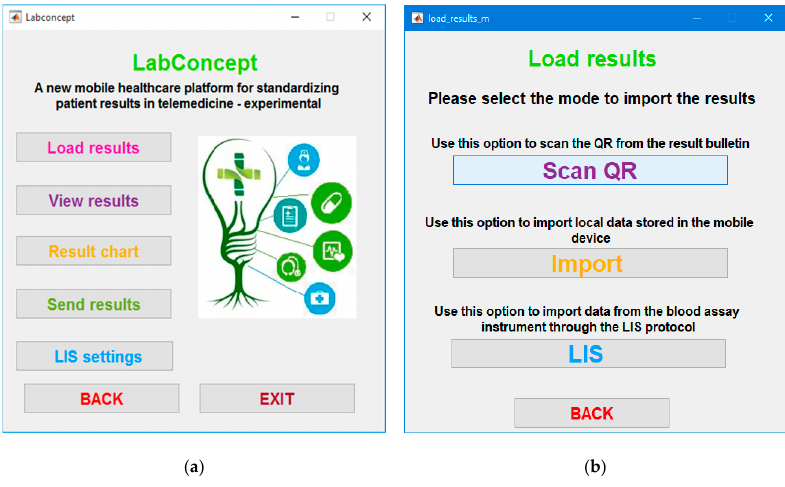
Figure 4. The LabConcept’s interface: ( a ) Main menu; ( b ) Load results menu.